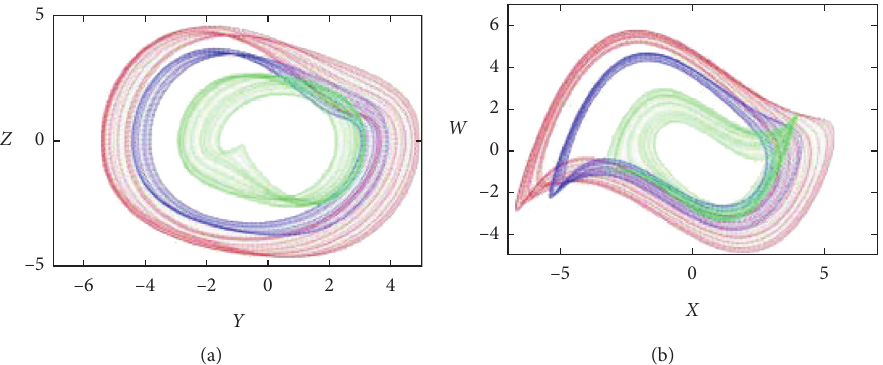
������ 􏽰 ������ 􏽰 ( 0 . 1/ d ) ) , ( 0 . 01/ ( 0 . 1/ d ) ) ,